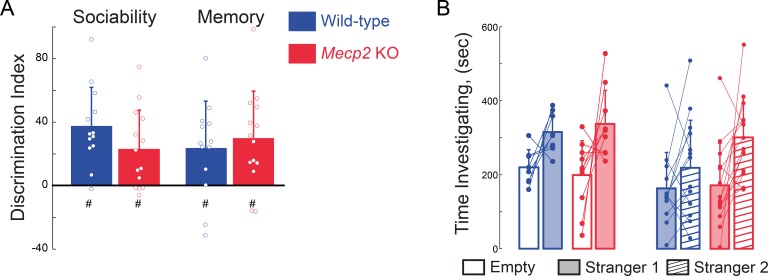
Social memory is not altered in presymptomatic Mecp2 KO mice.(A) Discrimination index of time spent investigating the empty inverted pencil cup or the cup containing either stranger 1 or stranger 2 (WT sociability, p=0.0001; Mecp2 KO sociability, p=0.0046; WT memory, p=0.0149; Mecp2 KO memory, p=0.0027; One-sample t-test against chance; WT vs.Mecp2 KO sociability, p=0.1394; WT vs. Mecp2 KO memory, p=0.6001; two-sample t-test; n = 8 WT mice; n = 10 Mecp2 KO). * denotes significant differences between groups, # denotes significant difference from chance values. (B) Absolute times for three chamber social task. Mean ± SD; *, # p<0.05, **p<0.01.10.7554/eLife.44182.018Figure 4—figure supplement 1—source data 1.VSD responses to vHIP stimulation in mPFC slices and LTP at vHIP-mPFC synapses are not altered in presymptomatic Mecp2KO mice.